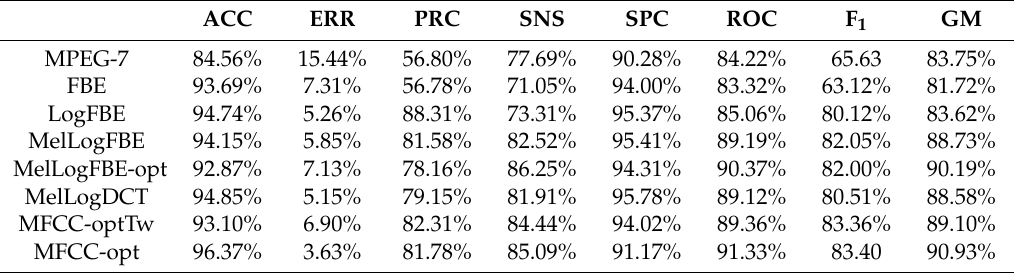
Table 11. Classification performance using various alternatives for the representation of the anuran call spectrum.